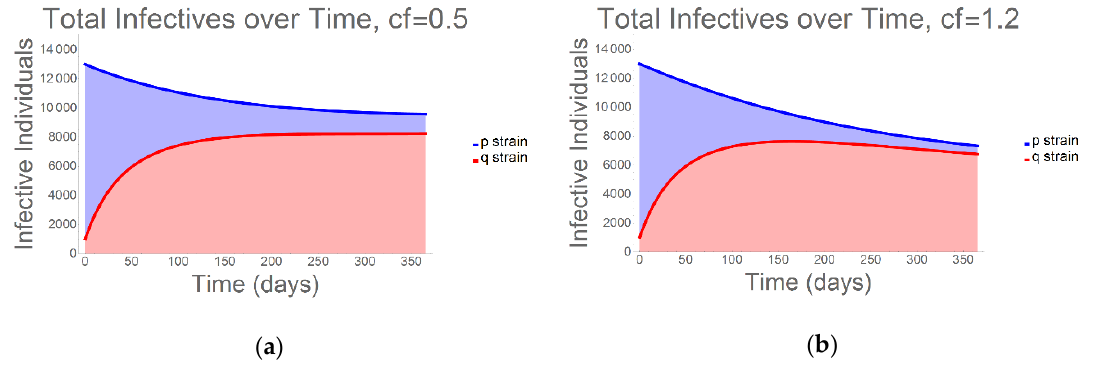
Figure 2. Total Infectivity: Again using ( a ) the lowest (cf = 0.5) and ( b ) the highest (cf = 1.2) resistant strain comparative fitness figures, we quantified the prevalence of the q-strain versus that of the p-strain for a one-year period. While there is a slight fitness-dependent change in the ratio of drug-sensitive to drug-resistant infections, the rapid q-strain dominance occurs even when its comparative fitness is low. Therefore, surveillance efforts that analyze total tuberculosis (TB) prevalence only, while failing to consider the percentage of resistant strain infectives within the population, could be critically flawed — especially when HIV/AIDS prevalence is high [10] .